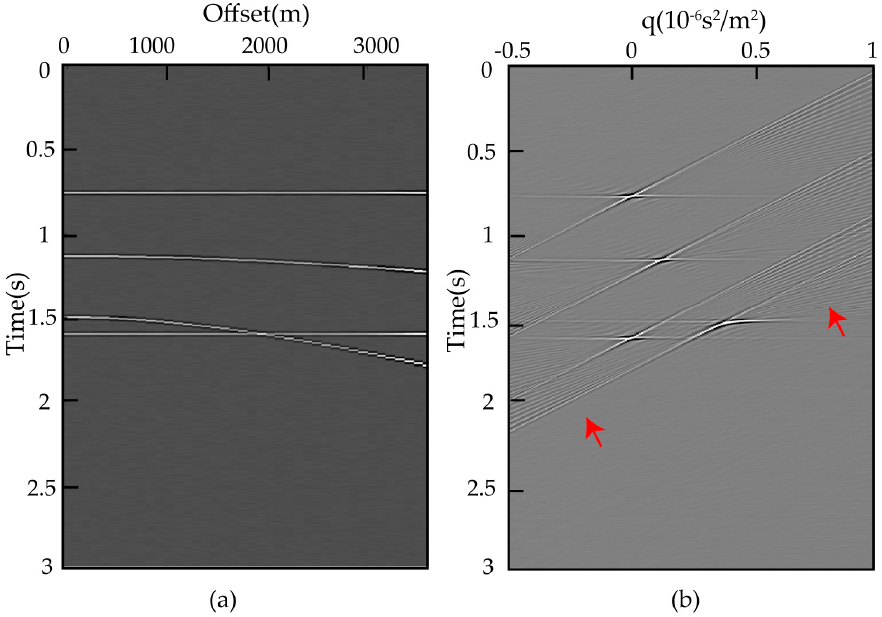
Figure 1. ( a ) CMP gather after NMO; ( b ) Radon domain data after parabolic Radon transform. The red arrows indicate the smearing.